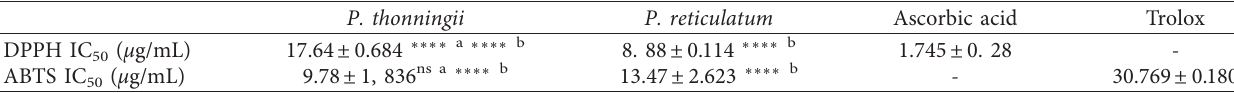
Table 3: DPPH IC 50 and ABTS IC 50 values of the two plants extracts and their standards.